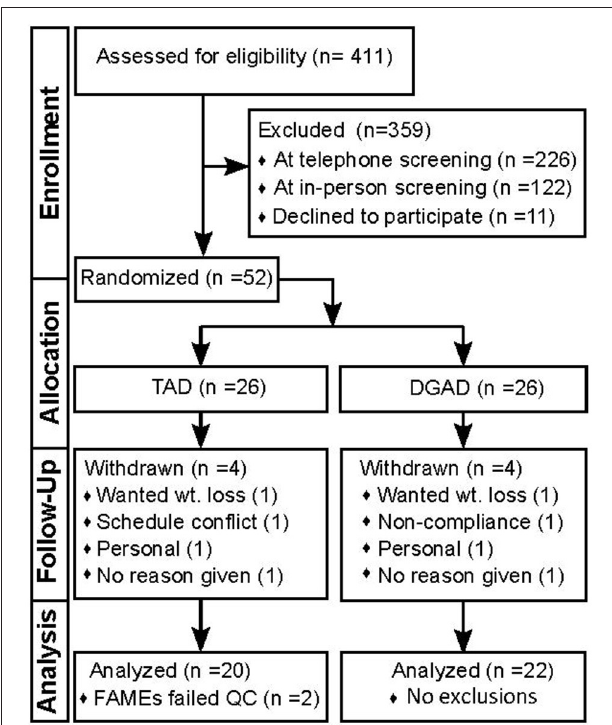
FIGURE 1 | Study flow diagram documenting participant enrollment, allocation, follow-up and analysis. This diagram conforms the Consolidated Standards of Reporting Trials (i.e., CONSORT). TAD, typical American diet; DGAD, Dietary Guidelines for American’s diet; FAMEs, red blood cell fatty acid analysis; QC, quality control criterion.